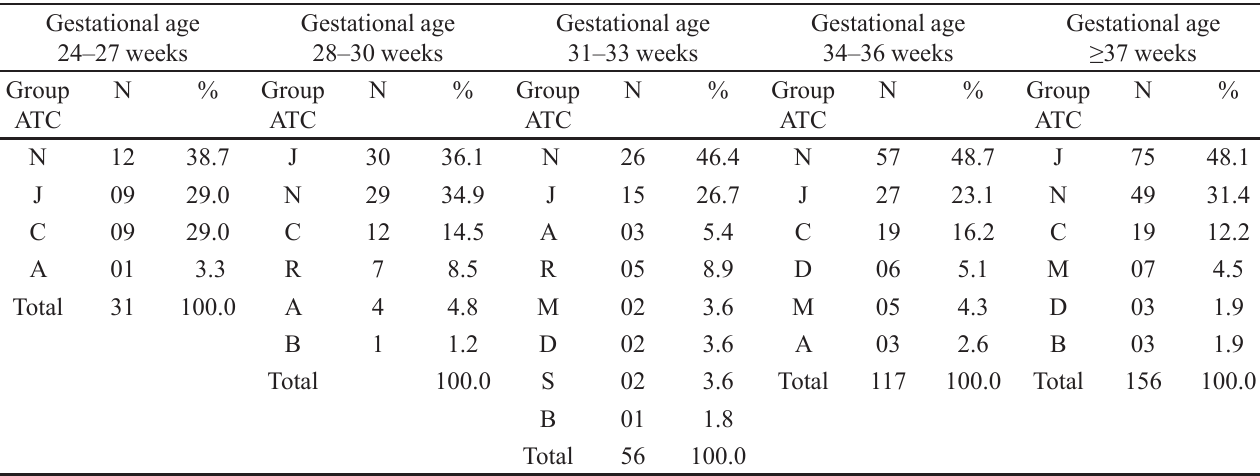
TABLE III - ATC group of drugs used off-label according to the FDA with a rate of use ≥ 4% among newborns, stratified